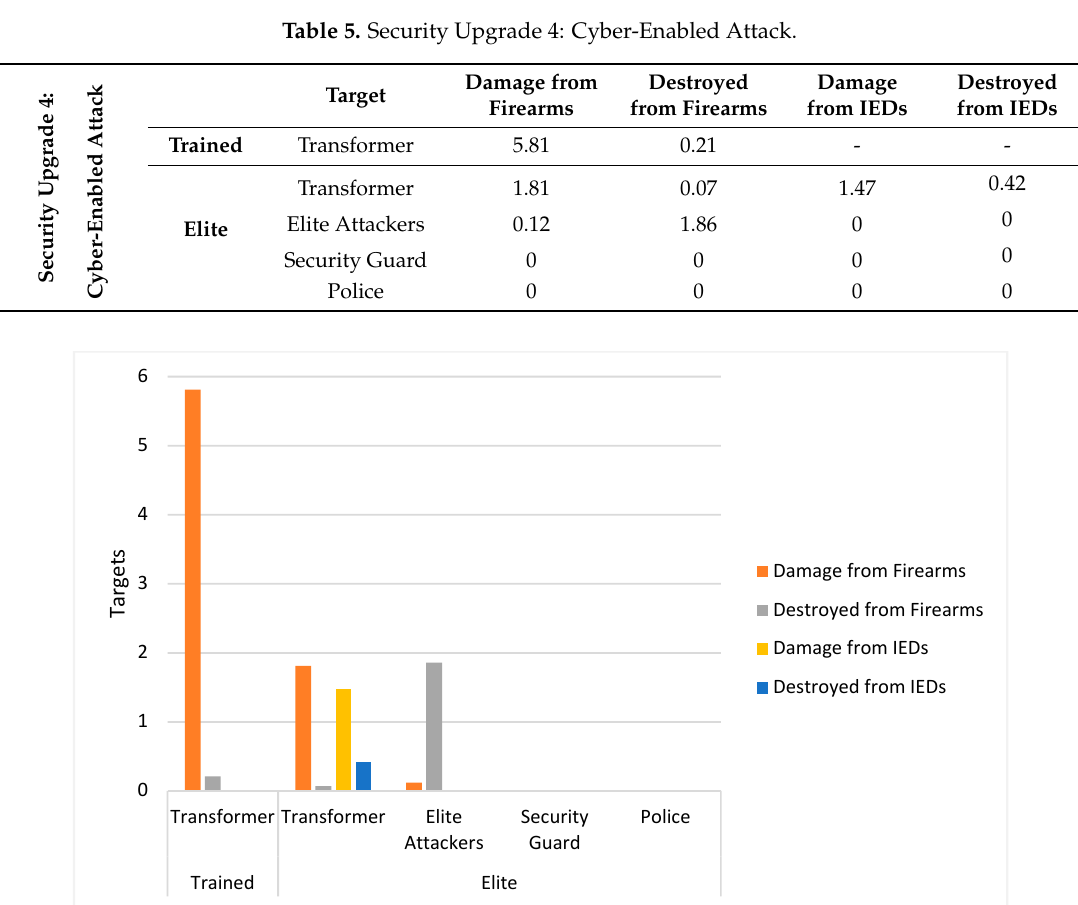
Figure 3. Damaged or Destroyed Targets in Cyber-Enabled Physical Attacks.